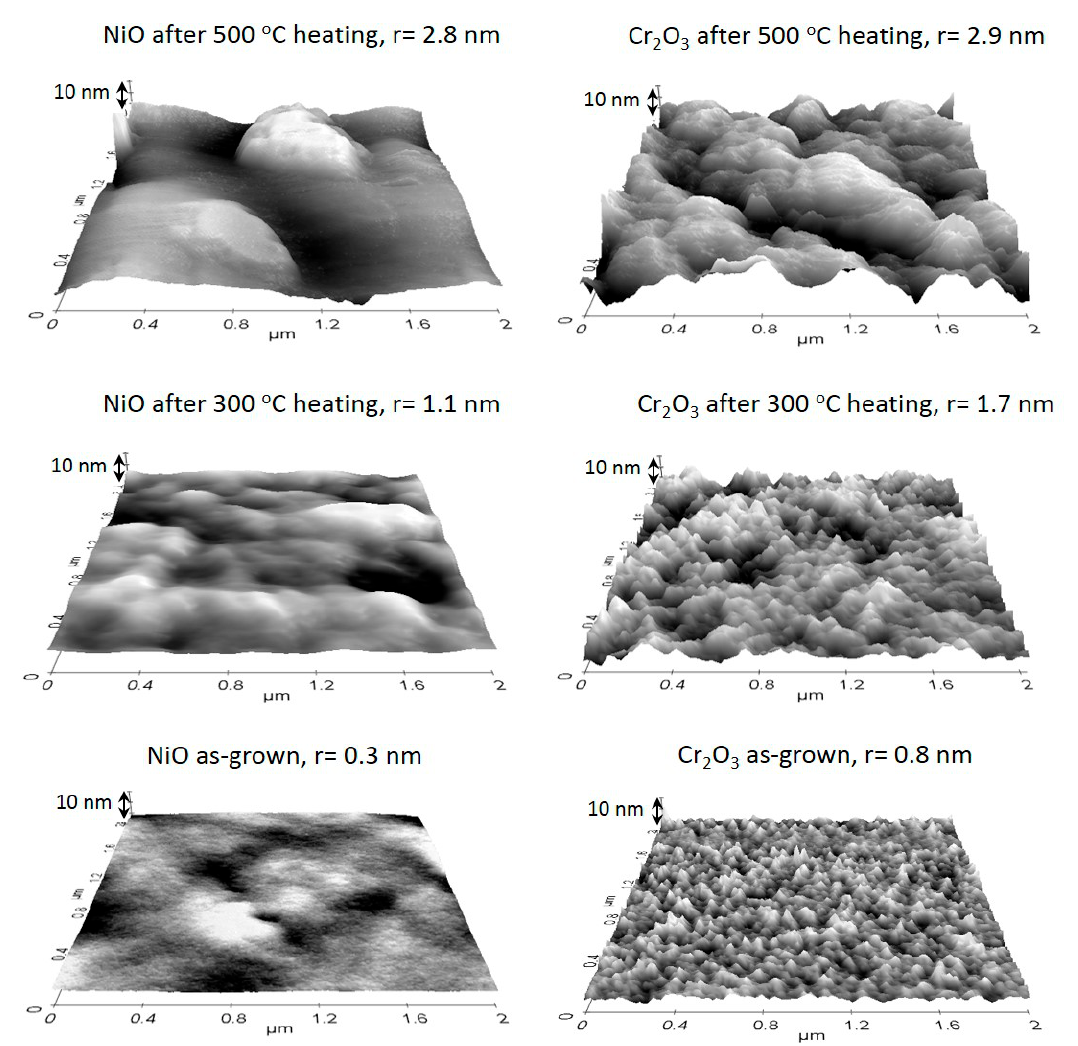
Figure 3. Atomic force microscopy (AFM) images taken on 2 μ m × 2 μ m areas for the various NiO and Cr 2 O 3 layers as-grown and after heating. The root-mean-square roughness (r) is included for each sample.